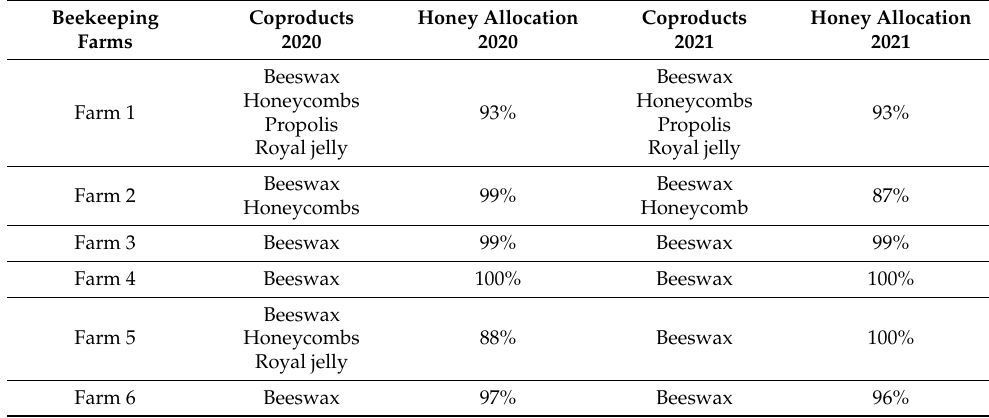
Table 2. Coproducts and allocation percentage on honey